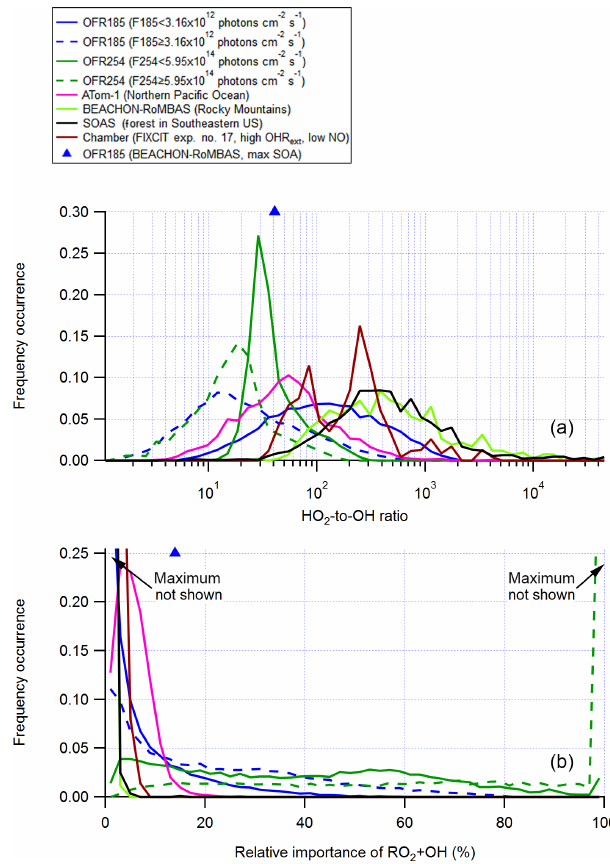
Figure 5. Frequency distributions of (a) the HO 2 -to-OH ratio and (b) the relative importance of RO 2 + OH in the fate of RO 2 (with medium self- and cross-reaction rate constant) for OFR185 (includ- ing OFR185-iN 2 O), OFR254-70 (including OFR254-70-iN 2 O), and a chamber experiment and in the atmosphere (a couple of differ- ent environments). The OFR distributions for lower (F185 < 3 . 16 × 10 12 photonscm − 2 s − 1 ; F254 < 5 . 95 × 10 14 photonscm − 2 s − 1 ) and higher UV (F185 ≥ 3 . 16 × 10 12 photonscm − 2 s − 1 ; F254 ≥ 5 . 95 × 10 14 photonscm − 2 s − 1 ) are shown separately. Only good and risky conditions (in terms of non-tropospheric organic photolysis) are included in the distributions for OFRs. Also shown are the HO 2 -to-OH ratio and the relative importance of RO 2 + OH for an OFR experiment with ambient air input in a field study (BEACHON-RoMBAS; Palm et al.,